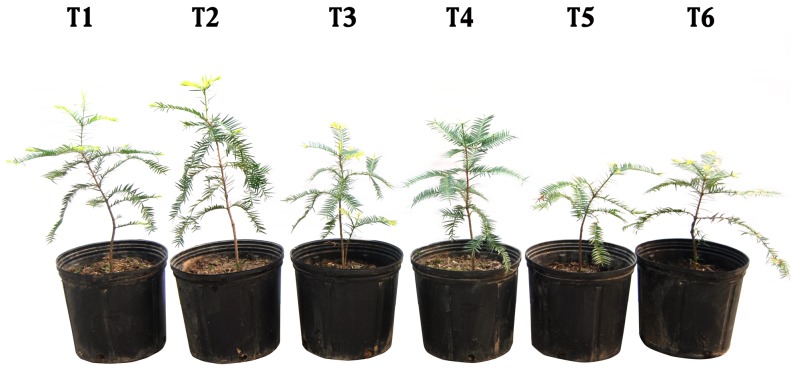
The appearance of whole plants in T. grandis seedlings.Treatments: T1, distilled water without SA; T2, distilled water with 0.5 mmol SA; T3, 0.2% NaCl without SA; T4, 0.2% NaCl with 0.5 mmol SA; T5, 0.4% NaCl without SA; and T6, 0.4% NaCl with 0.5 mmol SA.